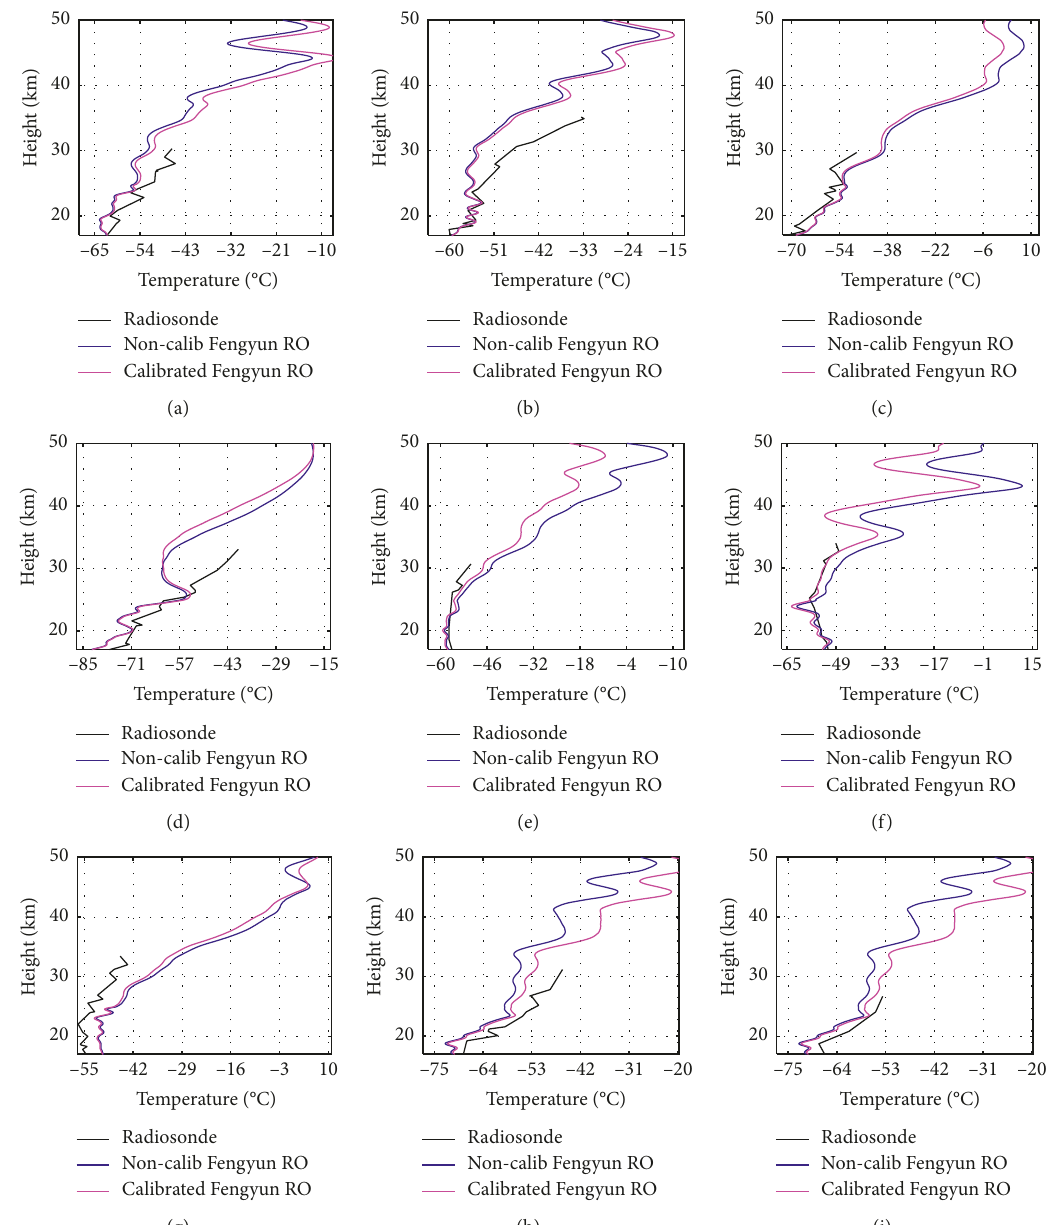
Figure 5: Effect of the ionospheric correction residual on the neutral atmospheric temperature estimation at 9 radiosonde